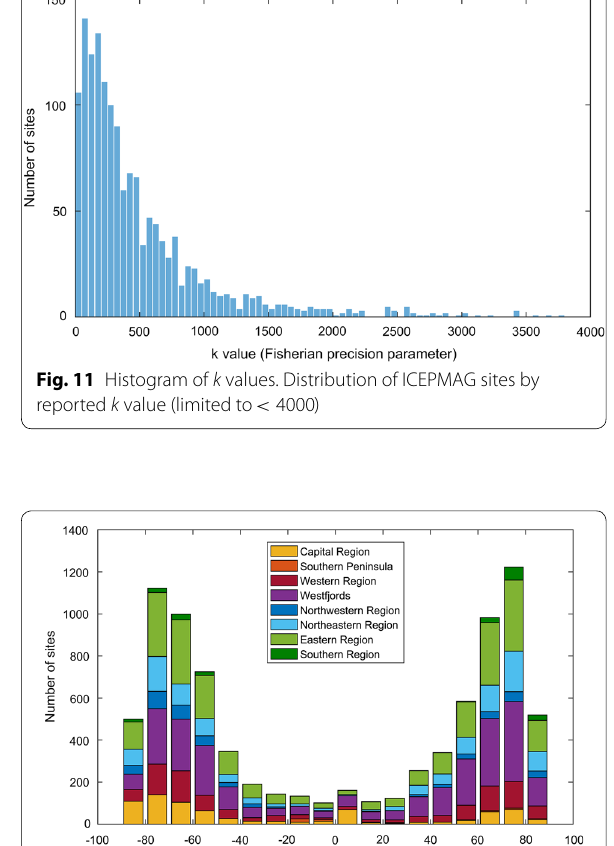
Fig. 10 Histogram of α 95 values. Distribution of ICEPMAG sites by reported α 95 value (limited to < 45 ◦ )